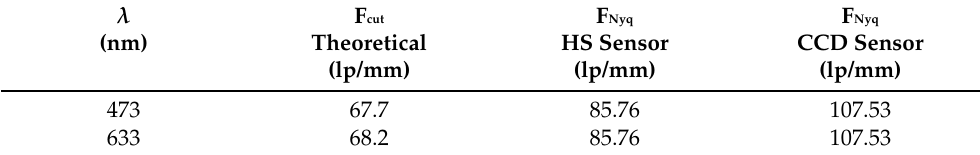
Table 4. Theoretical cut-off and Nyquist frequencies for the CCD and HS wavefront